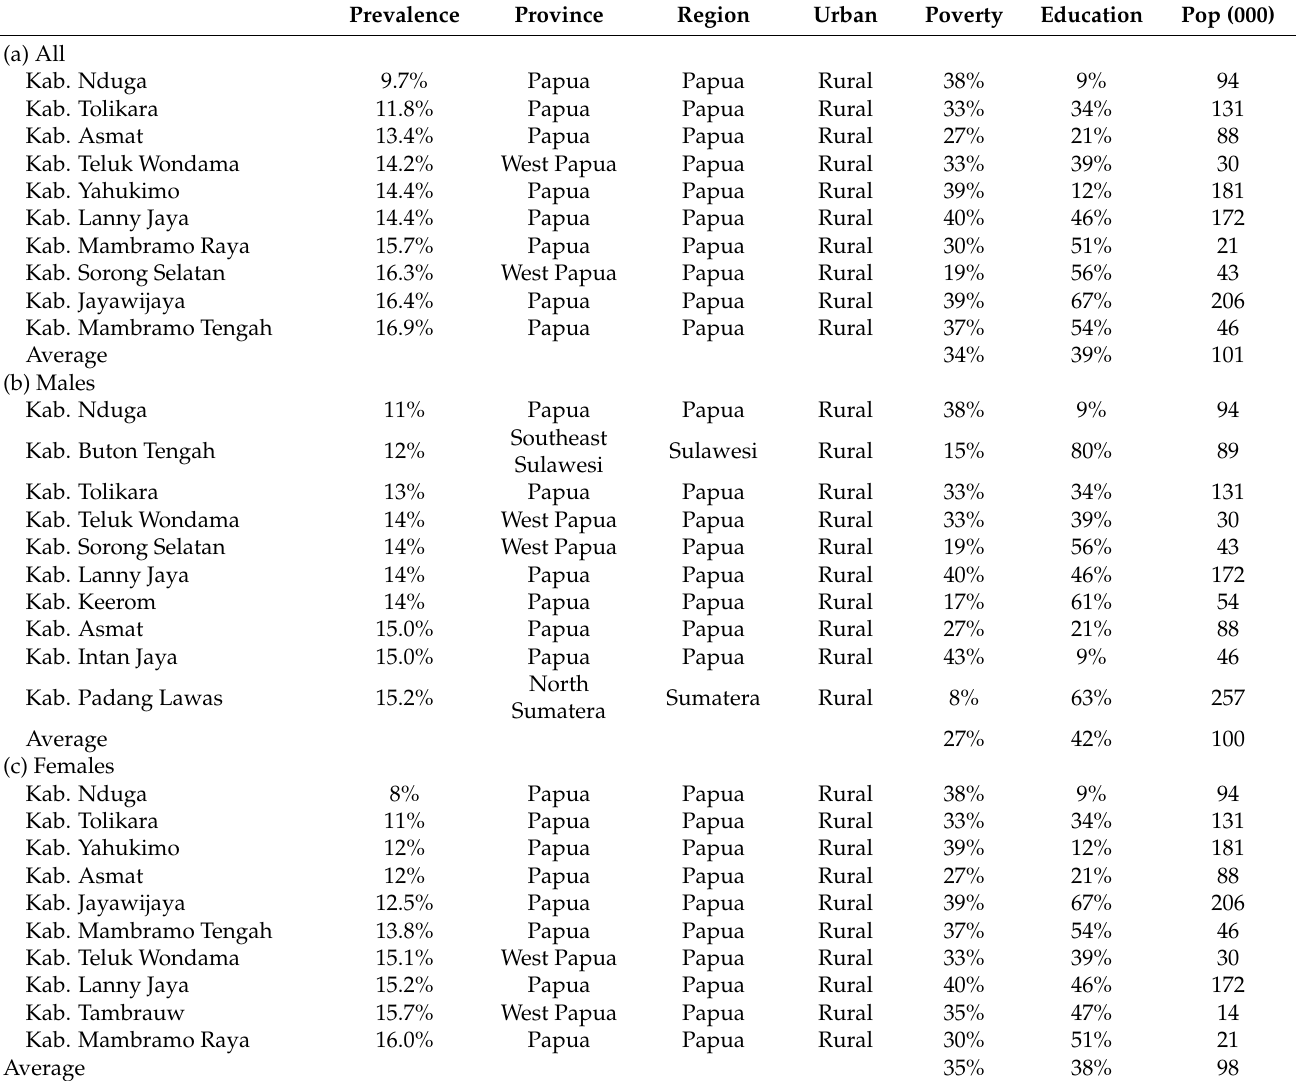
Table A2. Ten districts with the lowest prevalence of hypertension among adults in